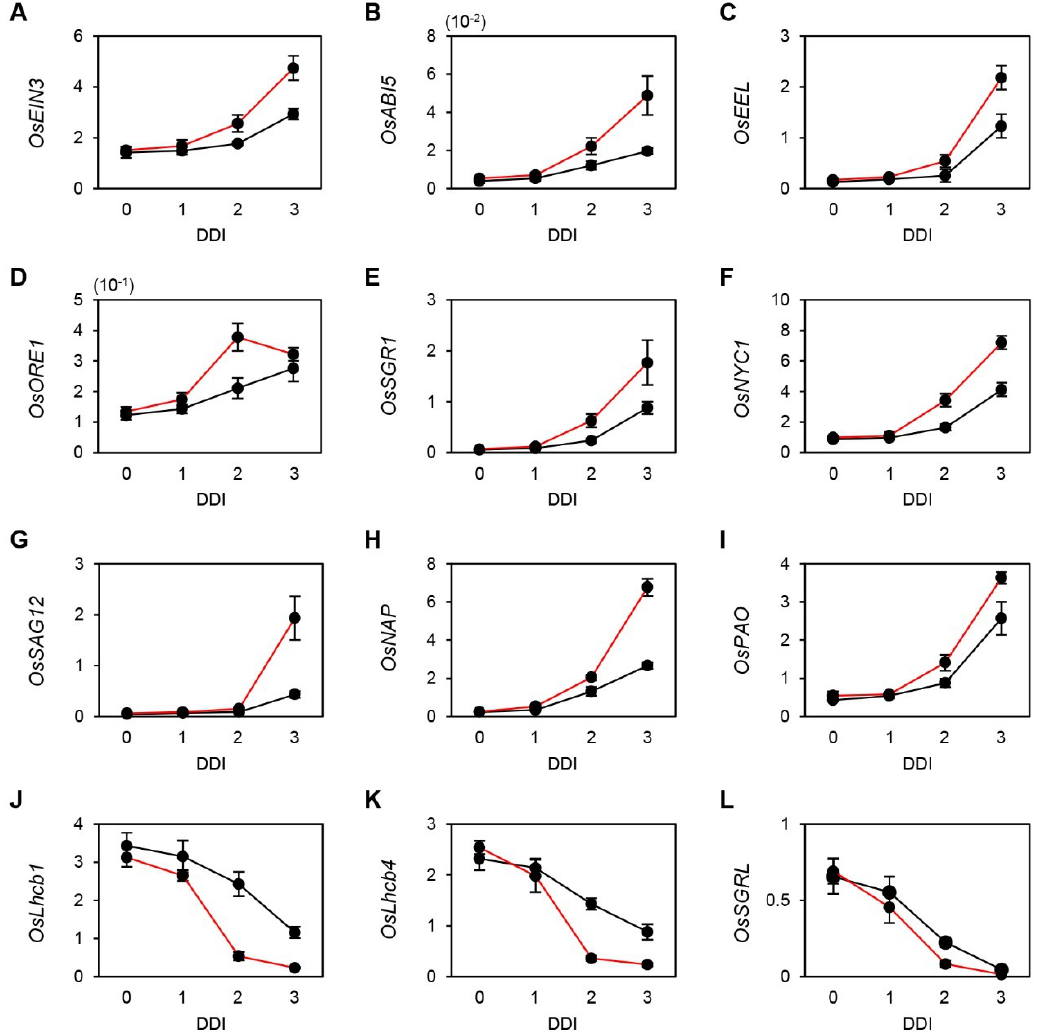
Figure 2. Expression of senescence-associated genes (SAGs) in WT and osphyB-2 during DIS. Detached leaf segments from one-month-old WT ( black line ) and osphyB-2 ( red line ) plants grown under LD conditions were incubated on 3 mM MES (pH 5.8) buffer with the abaxial side up at 28 °C in darkness, and were sampled at 0, 1, 2, and 3 DDI for RT-qPCR. RT-qPCR analysis was used to measure the relative transcript levels of OsEIN3 ( A ), OsABI5 ( B ); OsEEL ( C ); OsORE1 ( D ); OsSGR1 ( E ); OsNYC1 ( F ); OsSAG12 ( G ); OsNAP ( H ); OsPAO ( I ); OsLhcb1 ( J ); OsLhcb4 ( K ) and OsSGRL ( L ) and transcript levels were normalized to the transcript levels of OsUBQ5 . Mean and SD values were obtained from more than three biological replicates. These experiments were repeated twice with similar results. DDI, day(s) of dark